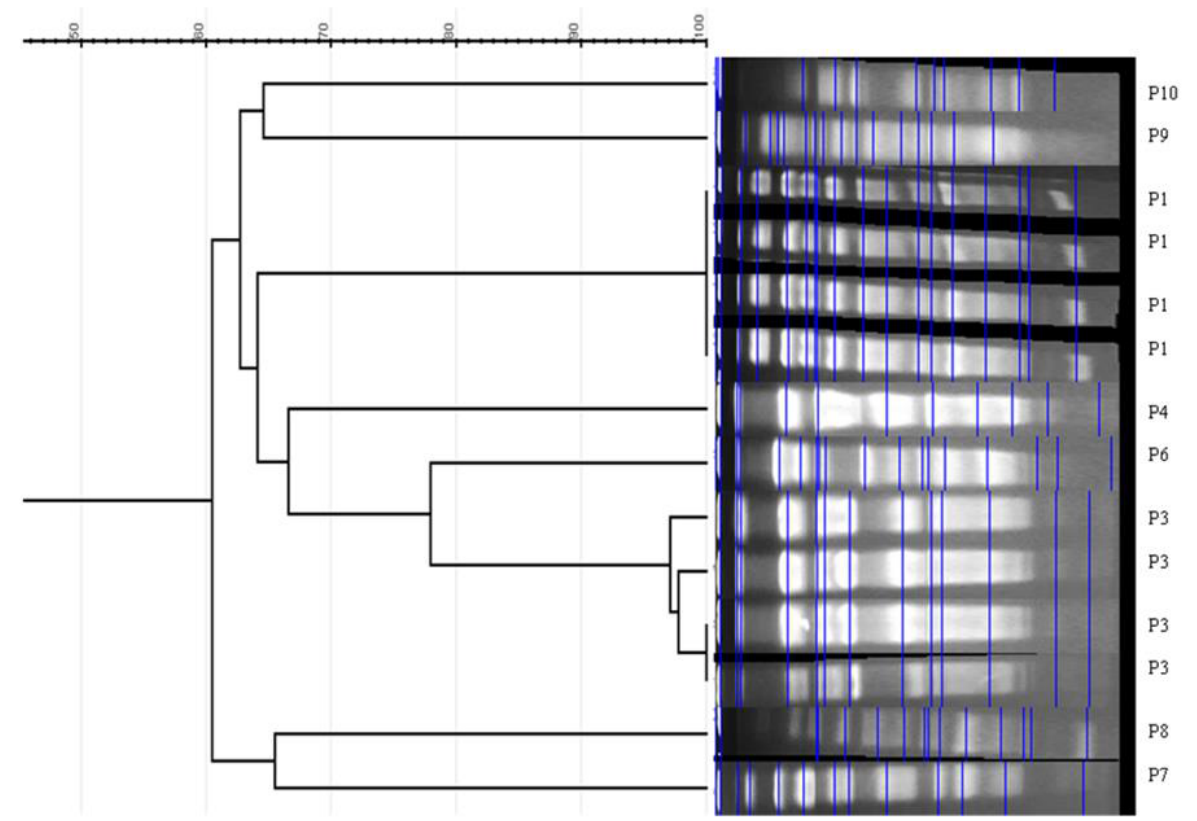
Figure 1. Representative PFGE cluster analysis of the main detected pulsotypes.